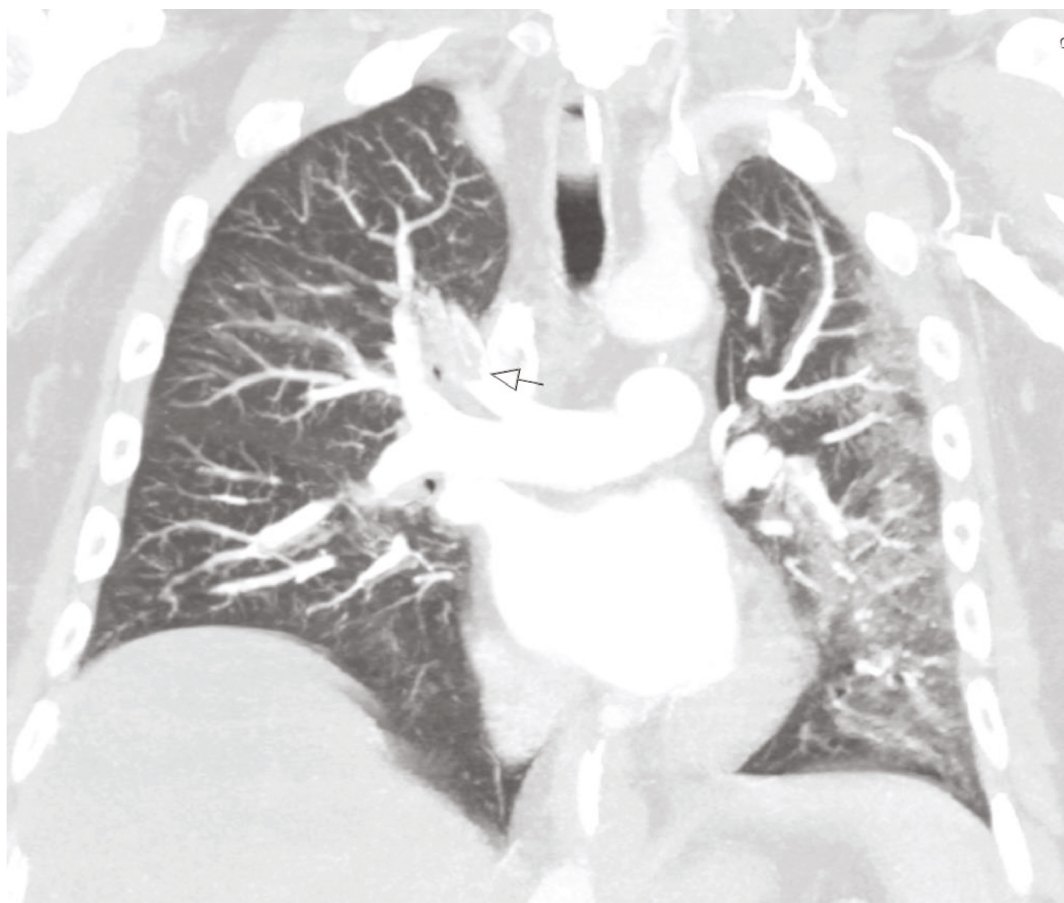
Figure 2: CT pulmonary angiogram performed on day 3 showing right-sided proximal segmental pulmonary